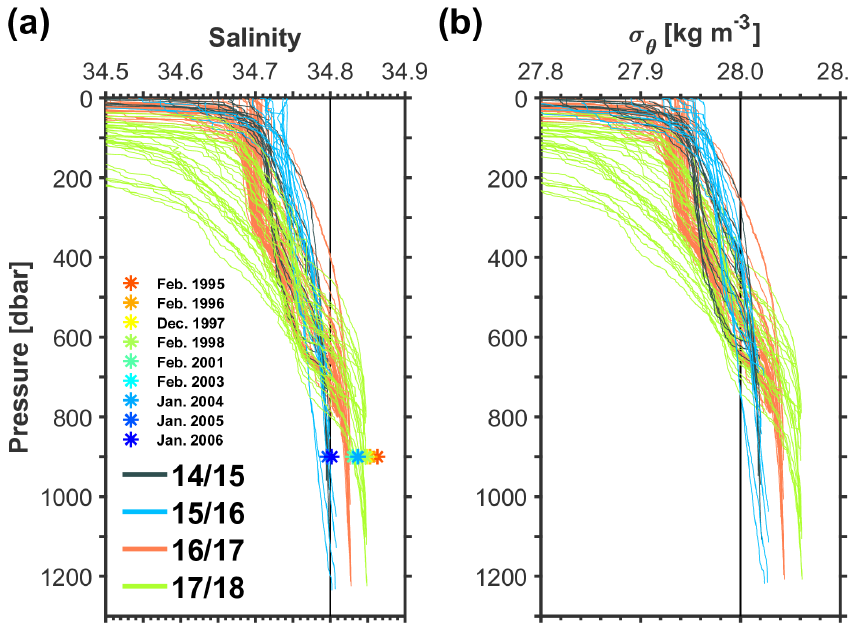
Figure 7. (a) Vertical salinity profiles at each observation period. The black solid line indicates 34.8. The asterisks indicate salinity at ∼ 900m of depth in TNB observed during 1995–2006 from Fusco et al. (2009) (b) The same as Fig. 7a, but for potential density ( σ θ ); the black solid line indicates 28.0kgm − 3